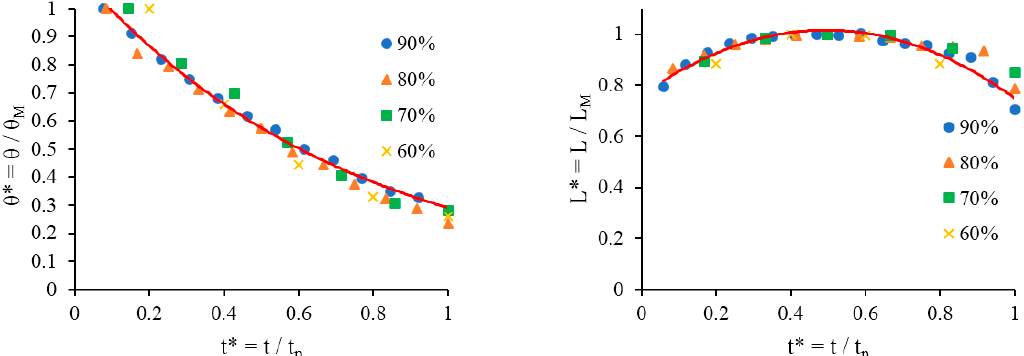
Figure 5. Contact angle and droplet base diameter dimensionless profiles for different concentrations of surfactant (%) on a dry audio sponge.